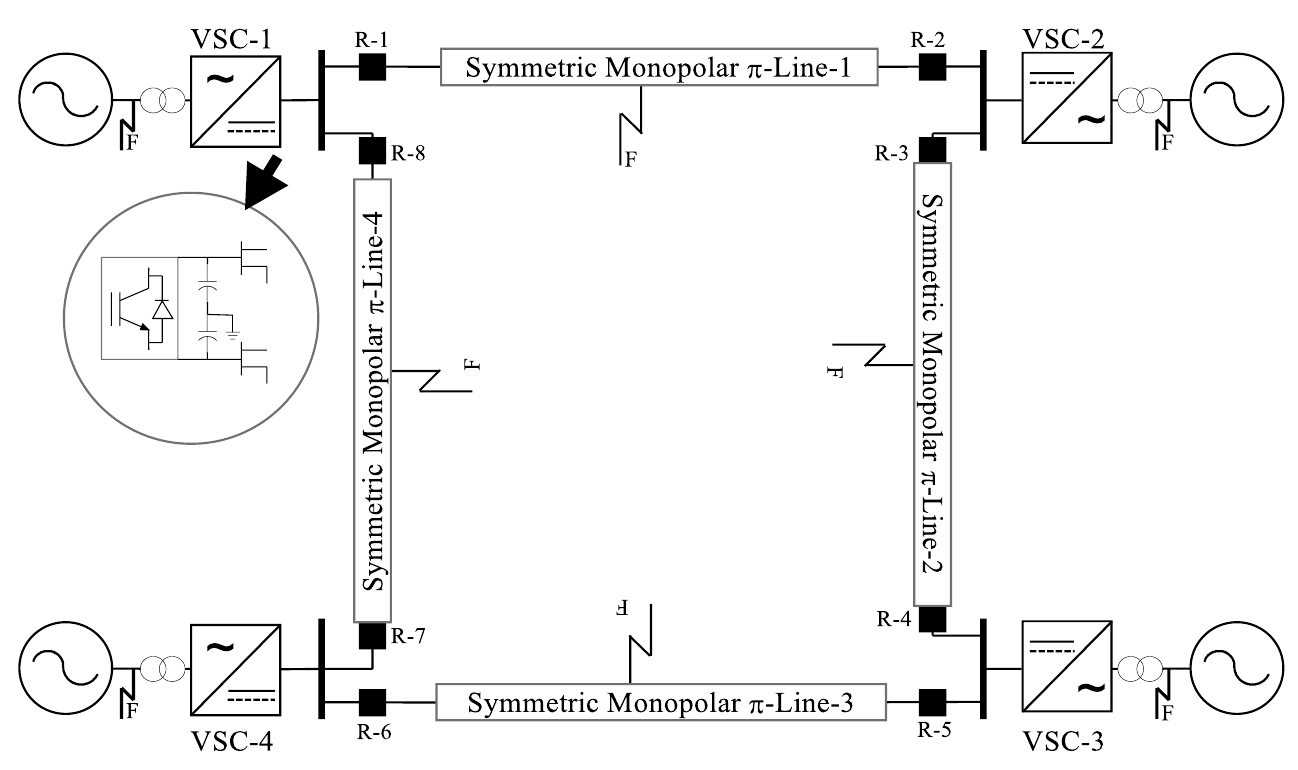
Figure 1. Studied symmetrical monopolar VSC-MT-HVDC system.